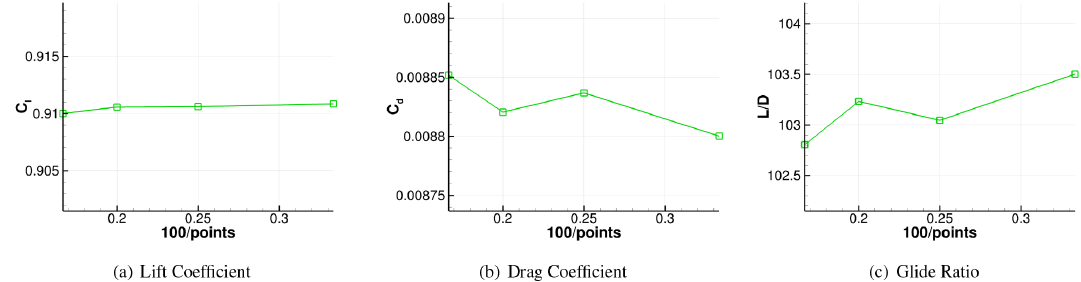
Figure B3. Grid resolution study for the DU93-W-210LM airfoil at α = 4 ◦ and Re = 9 × 10 6 (free-transition results using the two-equation model).